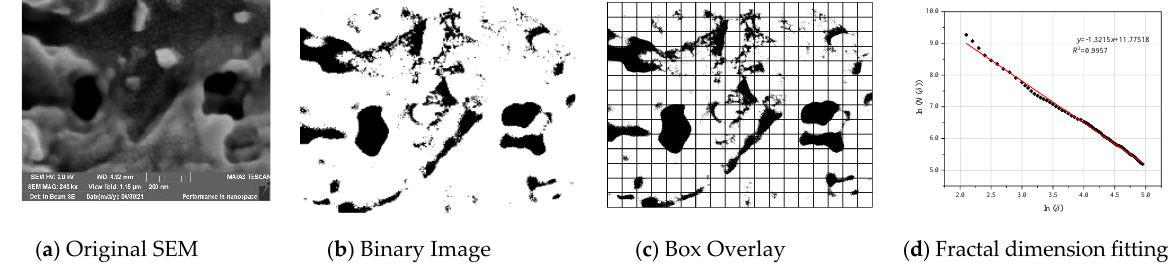
Figure 6. Schematic Diagram of Surface Fractal Dimension Calculation.